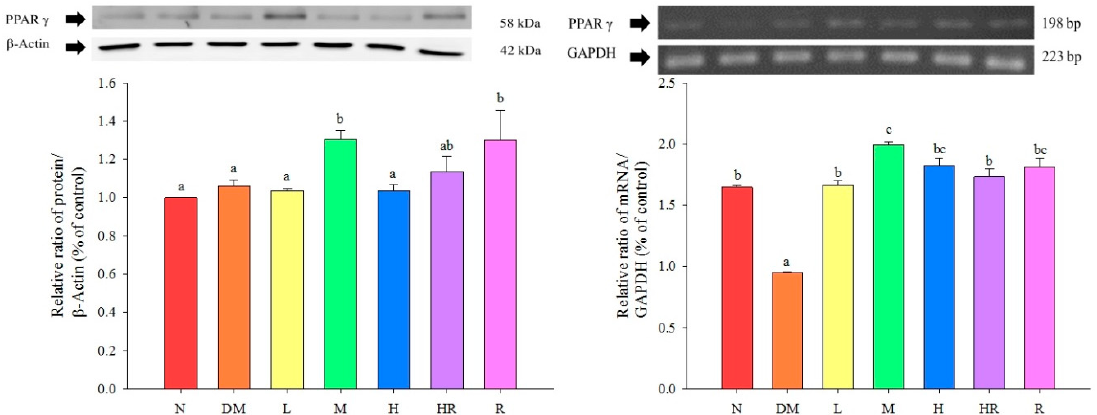
Figure 3. Influence of red guava on PPAR γ protein and mRNA expression in the mouse epididymal fat. The treatments were as follows: normal (N), diabetes mellitus (DM), diabetes + red guava 1% (L), 2% (M), and 5% (H), diabetes + 5% red guava + anti-diabetic rosiglitazone (HR), and diabetes + anti-diabetic rosiglitazone (R). Values are expressed as mean ± SD of each group. The lowercase letters above the bars indicate significant differences ( p < 0.05).